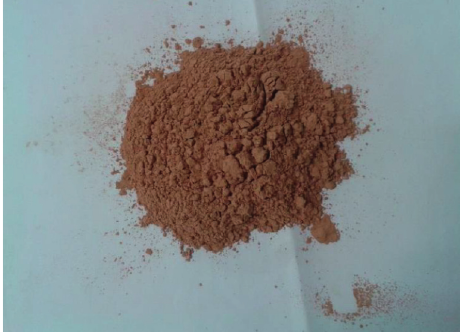
Figure 4: Ultrafine ceramic powders after grinding in a planetary